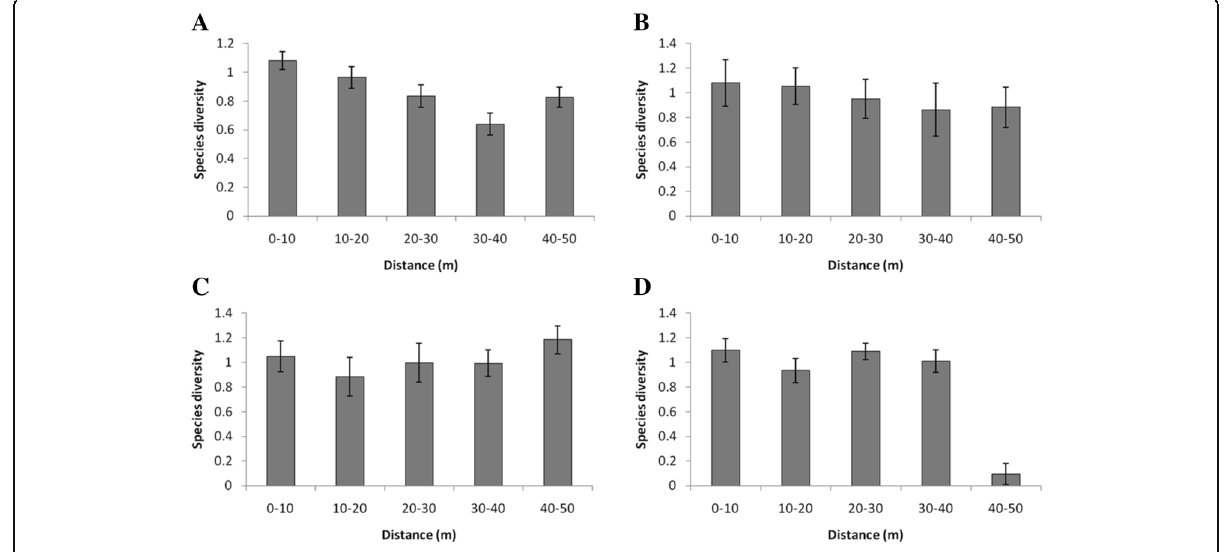
Fig. 5 Mean species diversity variation with distance from surface water in Boro ( a ), Seronga ( b ), Jao ( c ), and UPH ( d